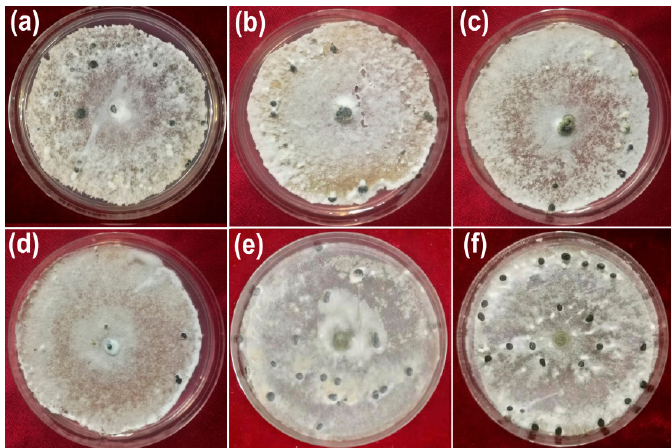
Figure 5. Effect of AgNPs on the sclerotia production of S. sclerotium 15 days after inoculation: ( a ) 50 Figure5. EffectofAgNPsonthesclerotiaproductionof S.sclerotium 15daysafterinoculation: ( a )50 µ g / mL; ( b ) 100 µ g / mL; ( c ) 150 µ g / mL; ( d ) 200 µ g / mL; ( e ) 50% cell-free culture liquid (CFCL); ( f ) ddH 2